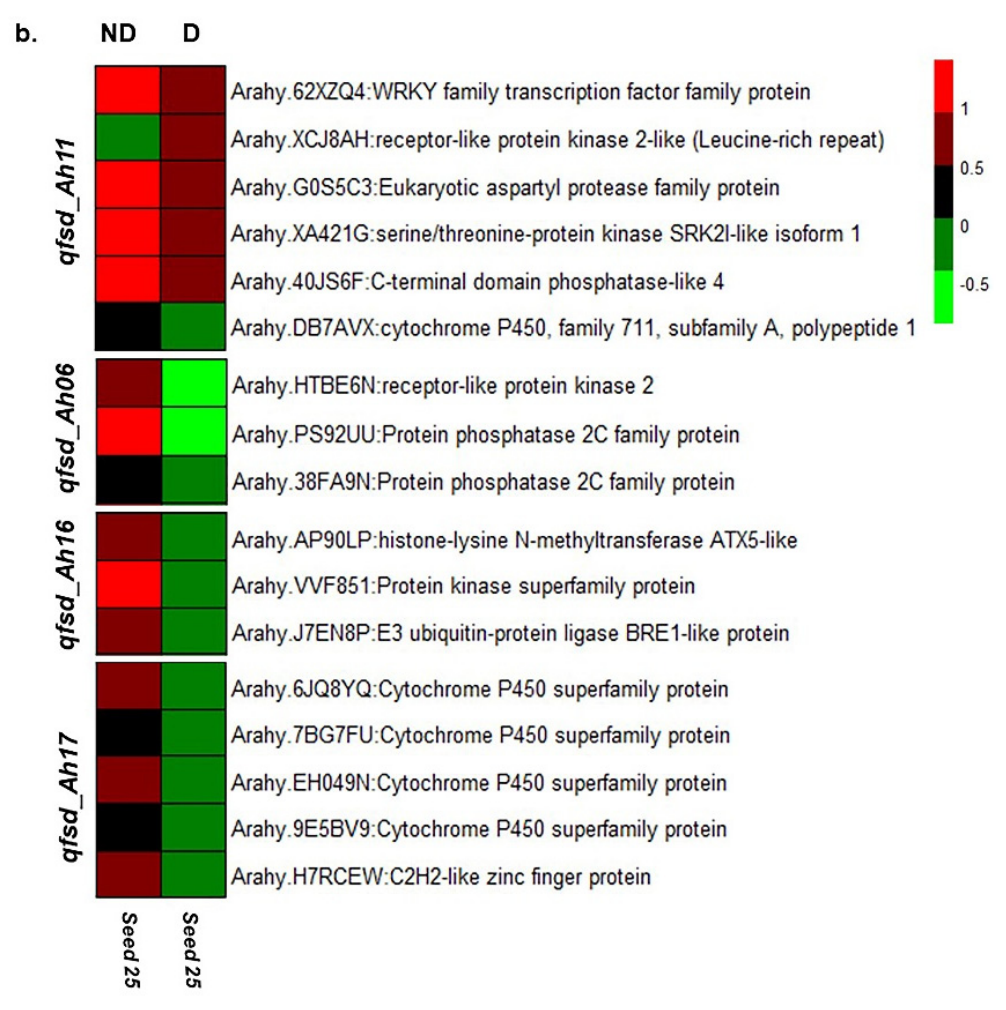
Figure 4. Heat map showing differentially expressed genes between dormant Tifrunner and non-dormant ICGV 91114 genotypes. The expression of selected genes in identified major QTLs during ( a ) seed and pod development stages and ( b ) only at seed_25 stage (mature seed) between dormant and non-dormant genotype .